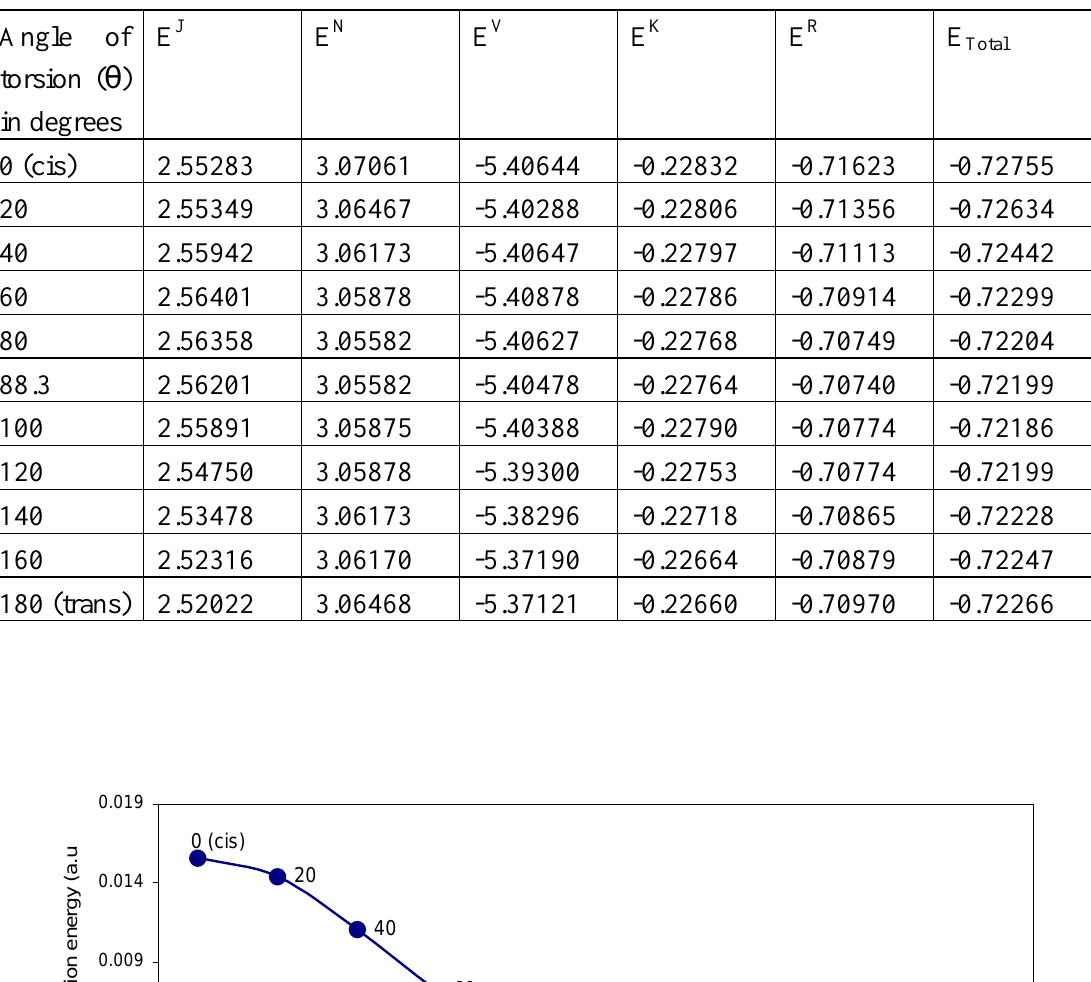
Table 4. The (O—H) bonding interactions and its decomposed components (a. u) in Hydrogen Peroxide with torsion.